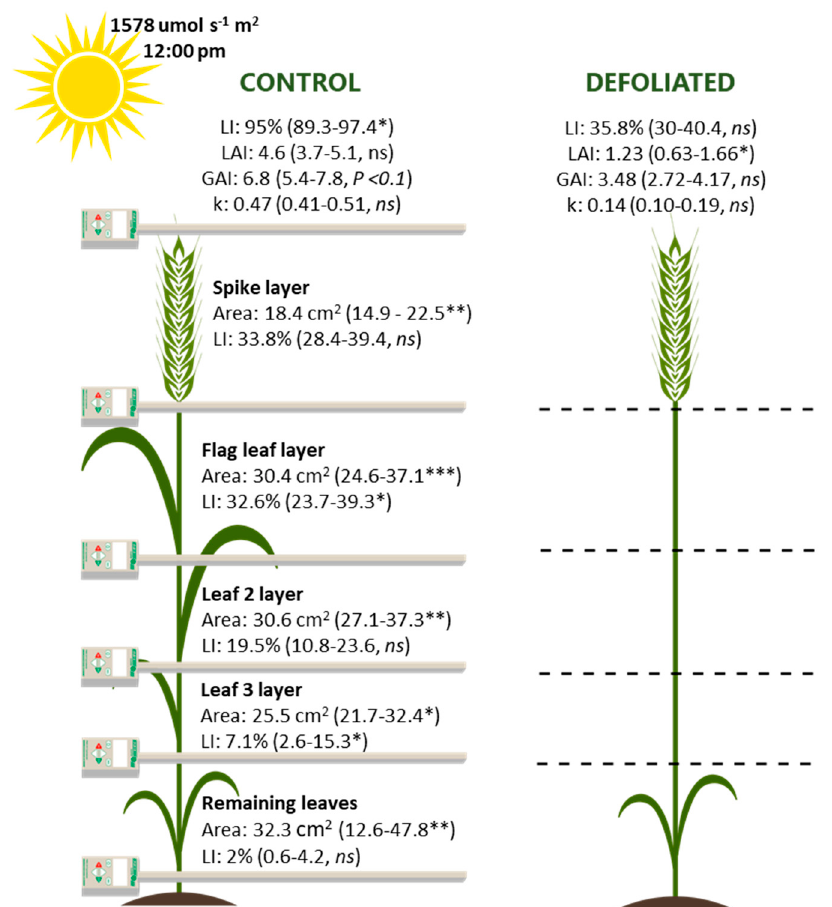
Figure 3. Overall and strata light interception (LI), leaf area index (LAI), green area index (GAI) and coefficient of extinction (k); and green area and LI per organ/strata (cm 2 ) in control shoots and estimation of overall LI, LAI, GAI and k in defoliated shoots measured at anthesis + 7 days (GS65 + 7). Means and ranges in 2013 for subset 1 (9 CIMCOG cultivars). * p < 0.05, ** p < 0.01, *** p < 0.001 and not significant ( ns ).